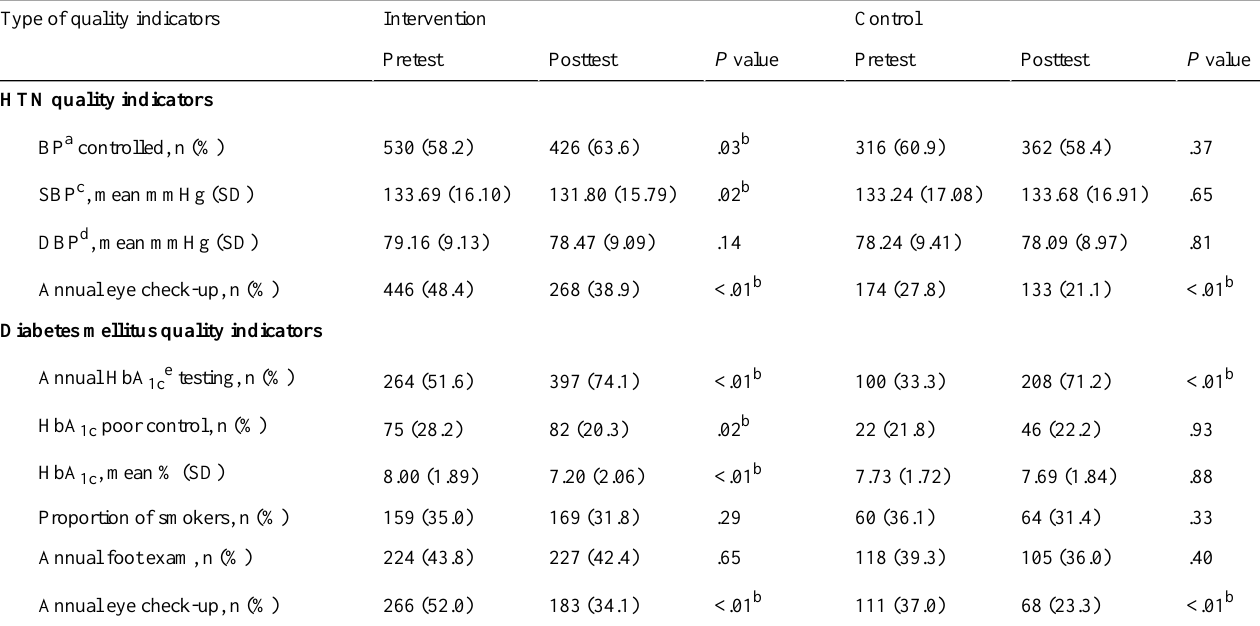
Table 3. Bivariate analysis of hypertension (HTN) and diabetes mellitus quality indicators by study group. ControlInterventionType of quality